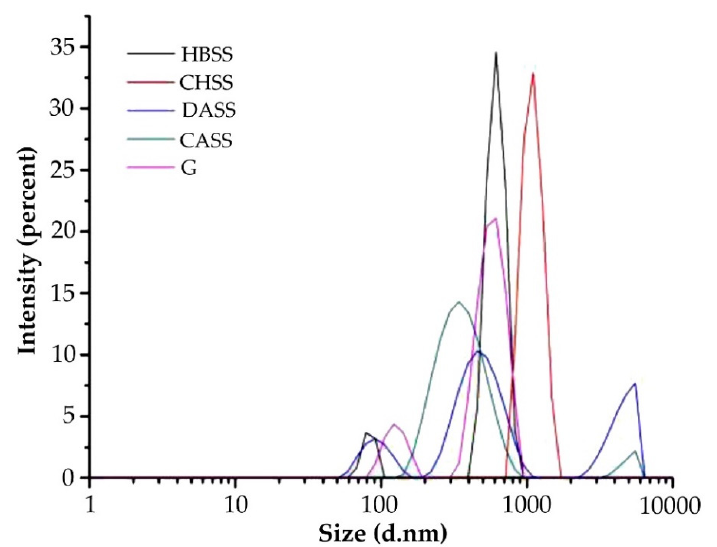
Figure 2. Particle size distribution of MLPs and gelatin (G).